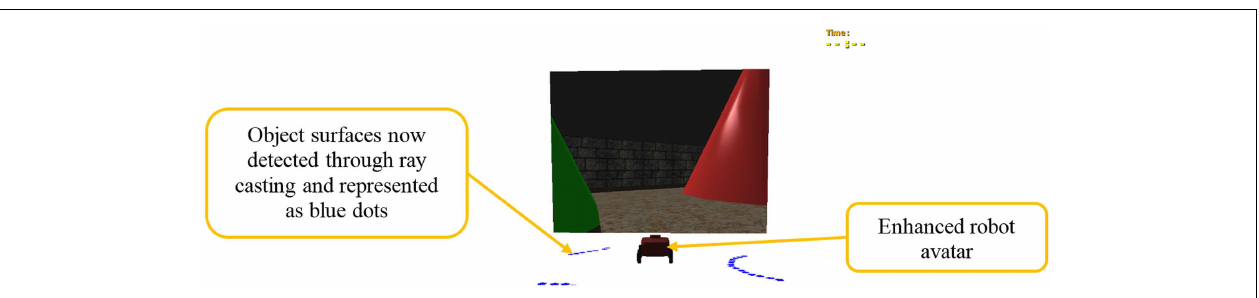
FIGURE 4 | Study #2 visual interface improvements .The ring feedback was not used in this study.